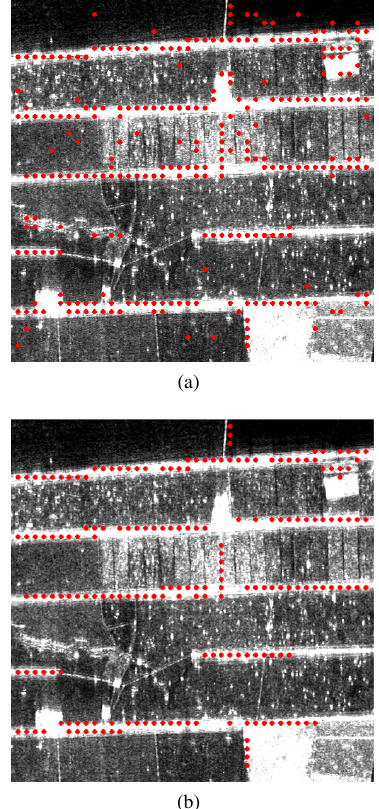
Figure 6: Results of the seeding (Cut 1): (a) Before of pruning process. (b) After of the pruning process.